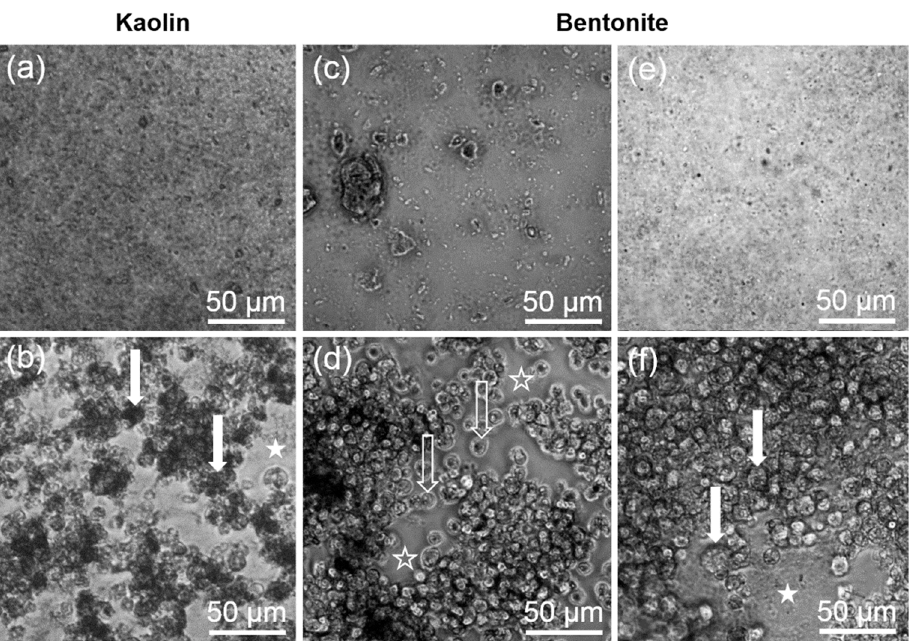
Figure 2. Gravitationally settled kaolin and bentonite particles, and uptake by NR8383 cells after 16 h. ( a , c , e ) Settled particles in cell-free control wells. ( b , d , f ) NR8383 cells incubated for 16 h with the same particles as shown above. (a,b) Kaolin (180 µ g / mL) after ultrasonic dispersion for 10 s. (c,d) Bentonite (180 µ g / mL) after ultrasonic dispersion for 10 s. (e,f) Bentonite (180 µ g / mL) after ultrasonic dispersion for 300 s. Filled arrows point to dark, particle-filled cells (b), or deteriorated cells with granular appearance (f). Filled asterisks mark areas where settled, non-ingested particle agglomerates are visible (b,f). Open arrows (d) show largely uncompromised cells; open asterisks (d) mark areas that had been cleared from particulate matter by phagocytosing cells.